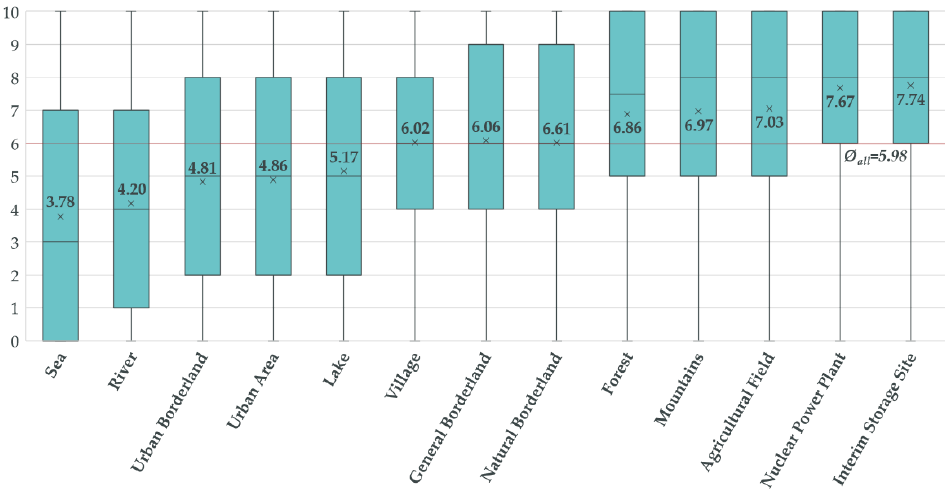
Figure 2. Assessment of different spatial site scenarios (SA; own data).